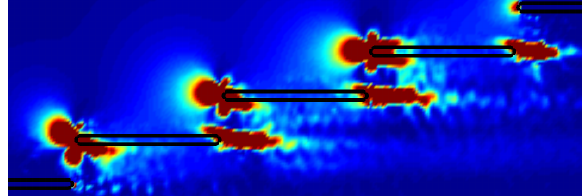
Fig. 13. Measured power spectral density of x -component of